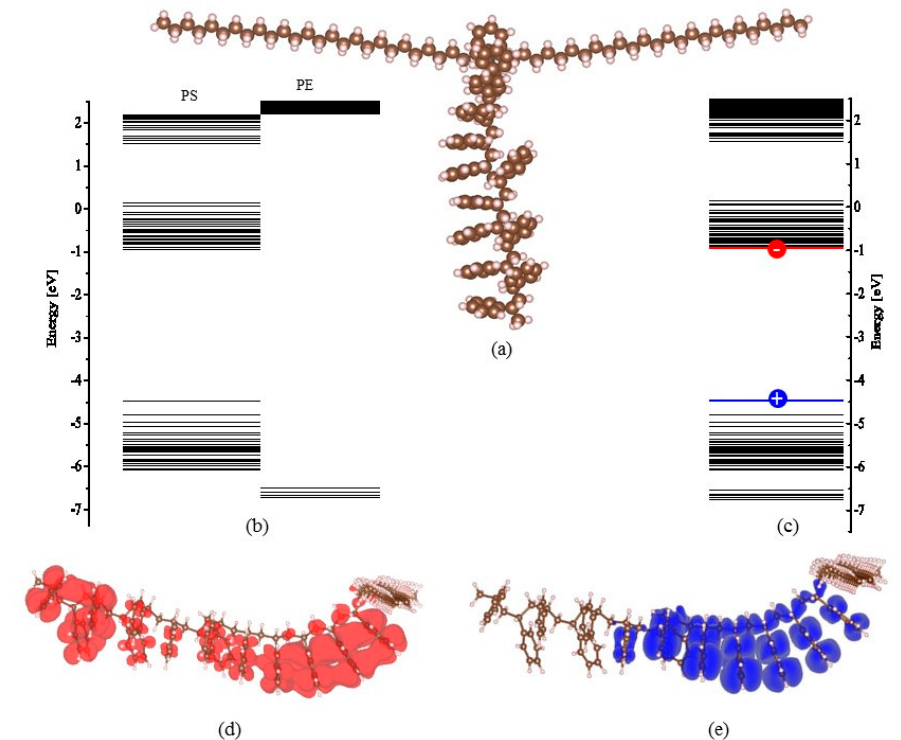
Figure 10. The chemical structure of LDPE-g-PS model ( a ) and the molecular energy levels of PS-g-LDPE molecule ( b , c ) and the highest occupied molecular and lowest unoccupied molecular orbitals ( d , e ).